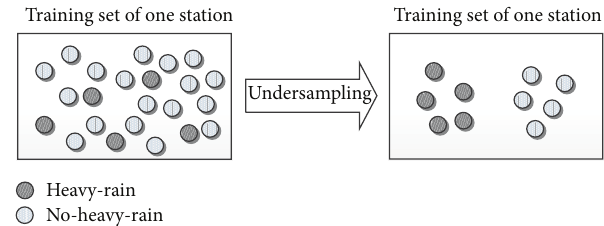
Figure 4: Example of our undersampling